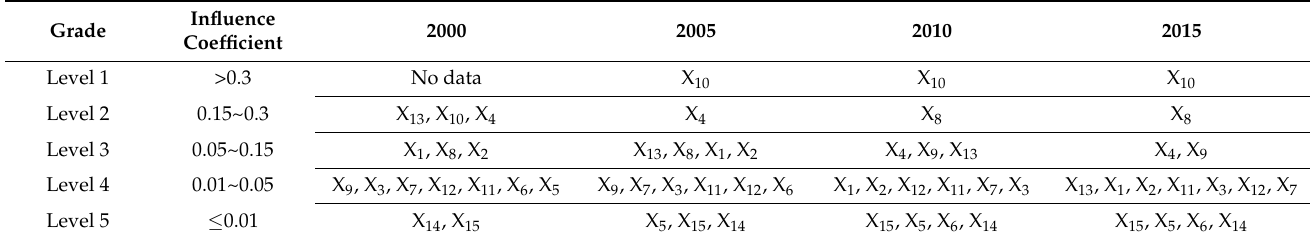
Table 6. Importance grading of ESV influencing factors in the Funiu Mountain